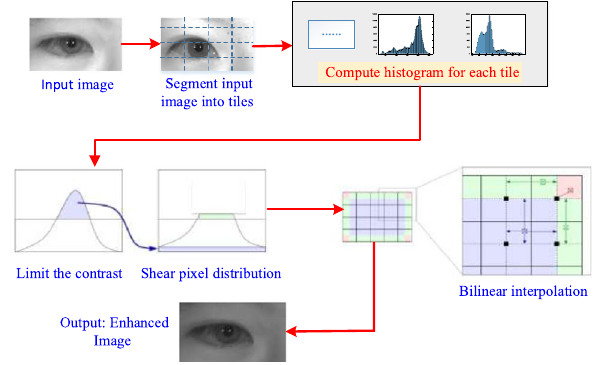
Fig. 2 Flowchart of